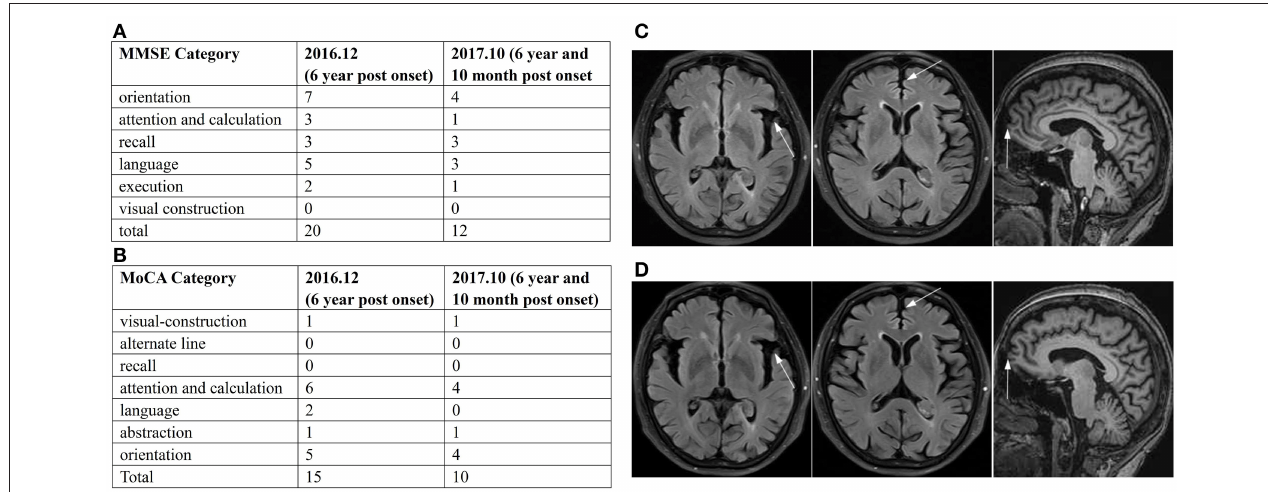
FIGURE 1 | Summary of MMSE and MoCA, and imaging data. Summary of MMSE (A) and MoCA (B) scores in Dec 2016 and Oct 2017 displayed the significant damage in cognitive function and decline trend with time. The brain MRI in Dec 2016 (C) and Oct 2017 (D) showed subtle atrophy of frontal and temporal lobes on transverse FLAIR weighted and sagittal T1 weighted